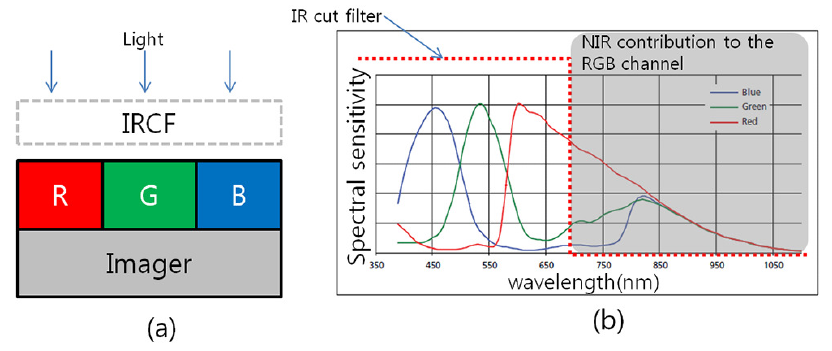
Figure 1. ( a ) Conventional camera system based on a color filter array (CFA) image sensor with the IR cut-off filter. ( b ) Spectral sensitivity of the camera